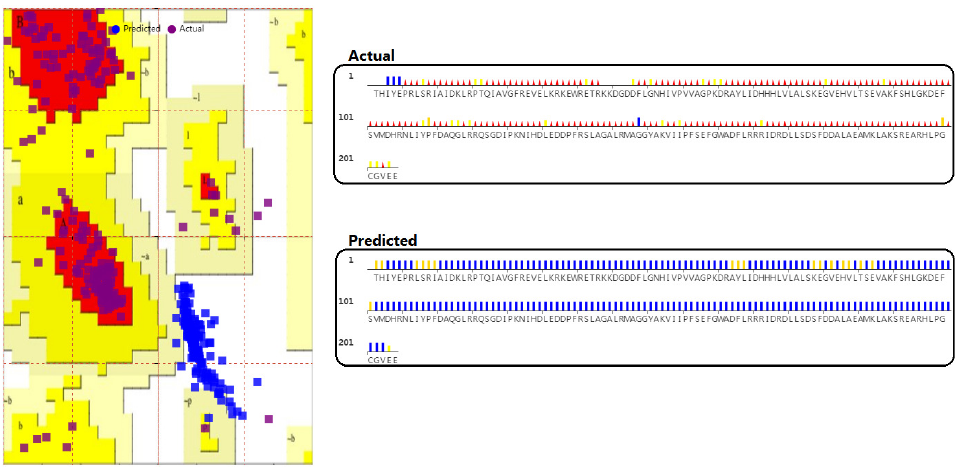
Figure 10. The left side shows the Ramachandran Plot of the certain protein chain, the right side shows the PictorialBar (the upper PictorialBar indicates the predicted structure, the lower PictorialBar is the actual structure) is the area corresponding to the chain residues, and check whether there are missing coordinates. The color of each pictogram corresponds to the area in the Ramachandran Plot, and the left Ramachandran Plot disallowed area (white) is displayed in blue in the